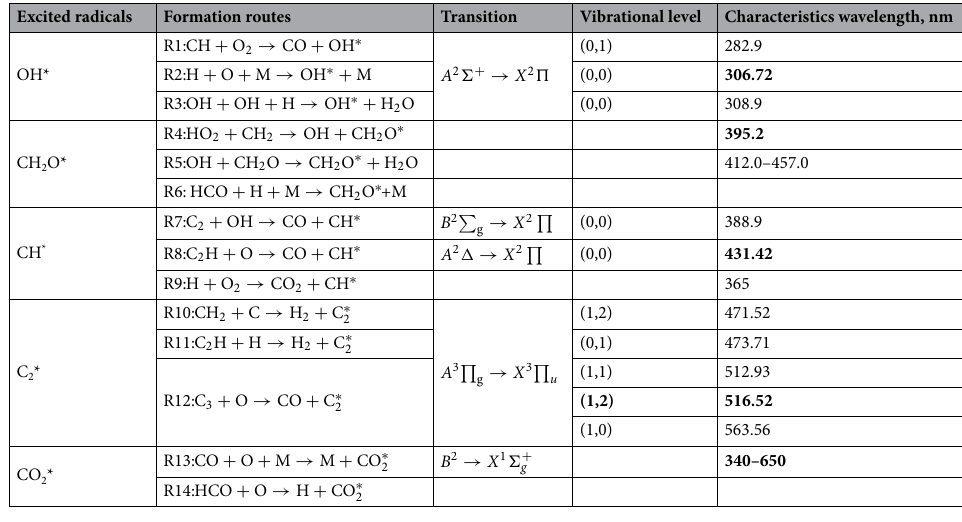
Table 3. Formation routes (based on elementary reactions) and characteristic wavelengths of excited radicals in a combustion process 38 . Prominent ones are shown in bolded 39 .